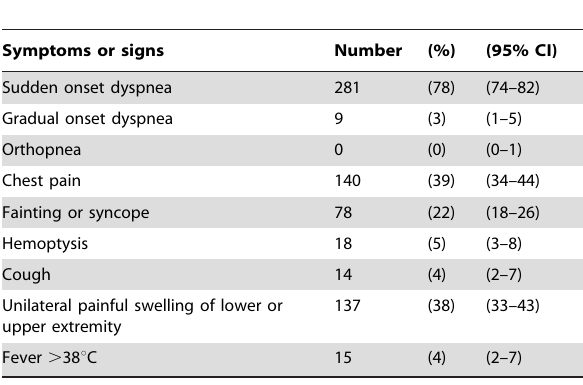
Table 3. Prevalence of symptoms and signs in 360 patients with pulmonary embolism (Firenze sample).